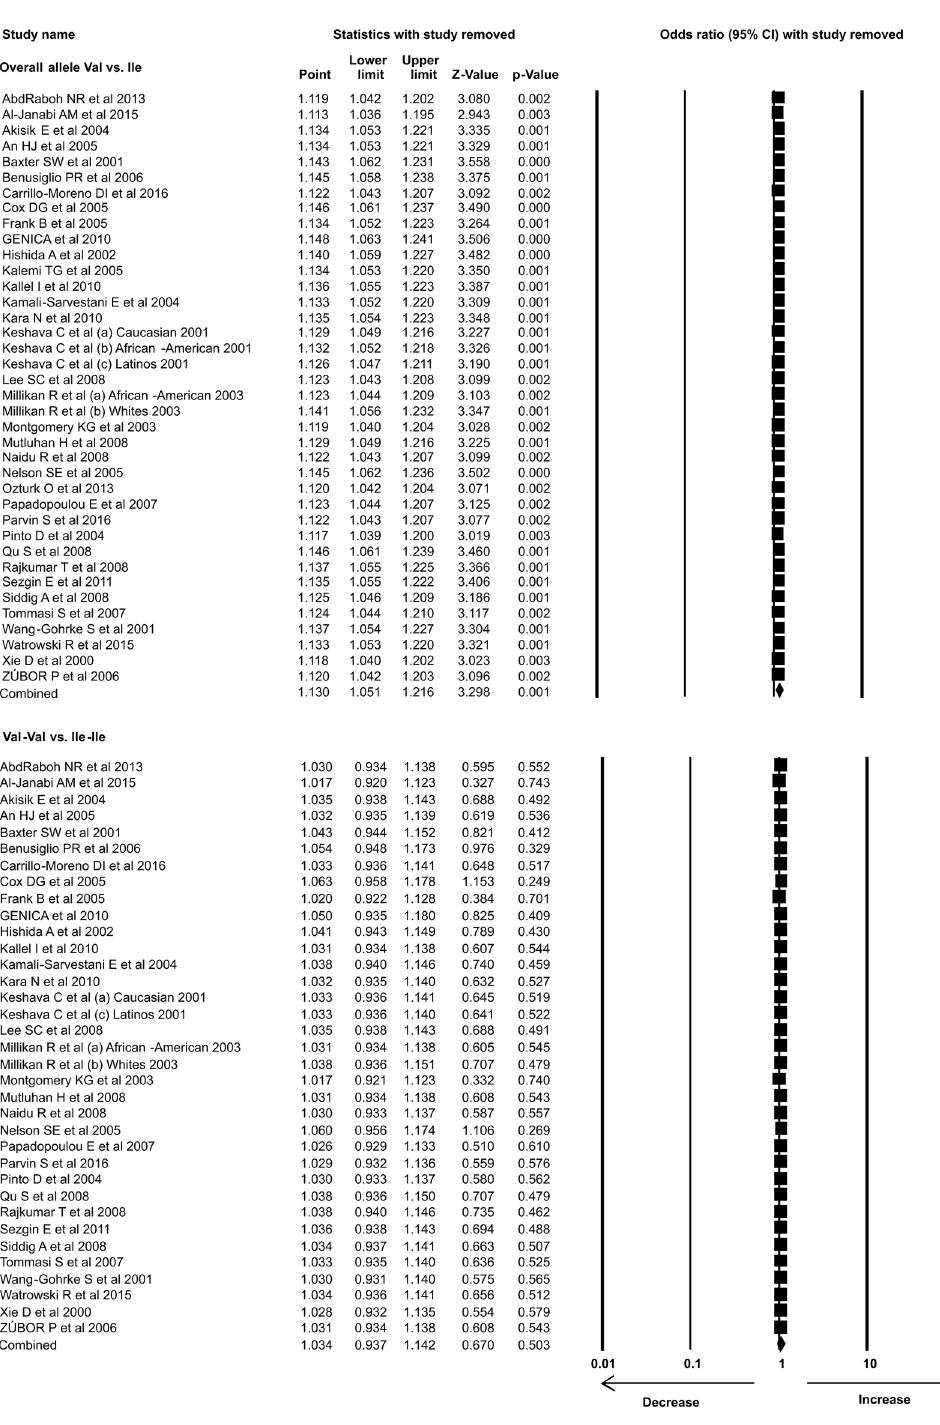
Figure 13. Sensitivity analysis: Sensitivity analysis showing no effect of single study on odds ratio (OR) in overall allele and genotypic (Homozygous: Val-Val vs Ile-Ile) analysis